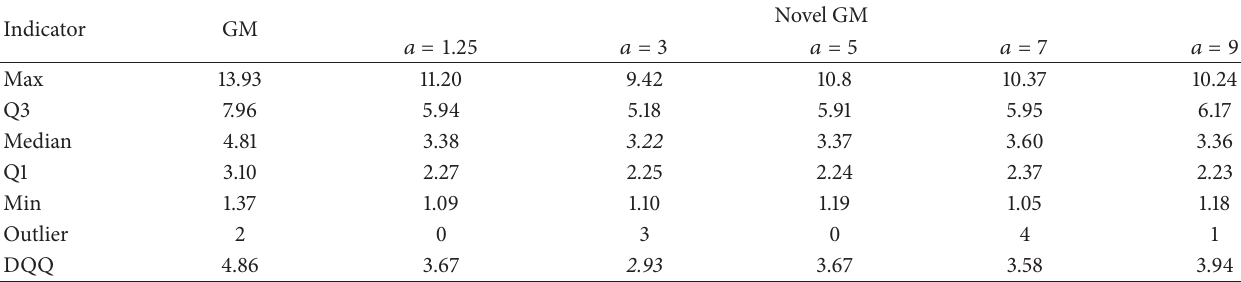
Table 1: Values of indicators in box plot of RMSEs at different values of 𝑎 in the novel GM and GM.